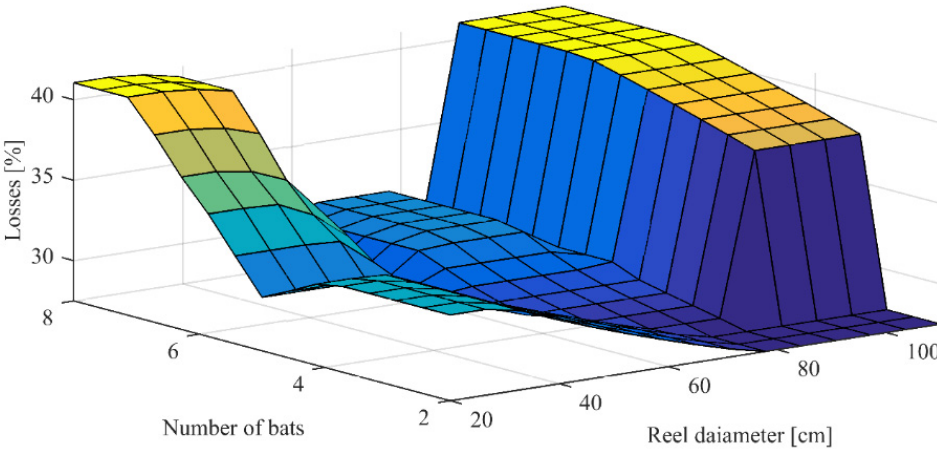
Figure 5. Relationship between shattering losses and reel functional operators, number of bats and reel diameter in the fuzzy model.